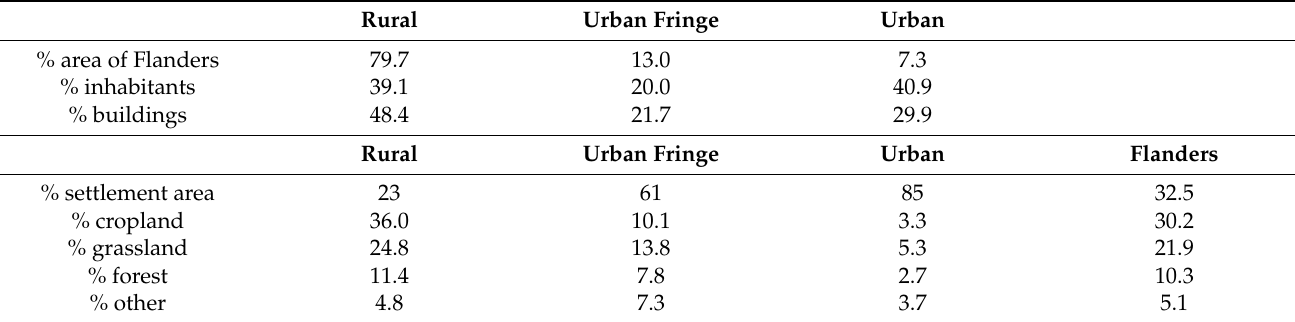
Table 2. Composition of Flanders regarding rural area, urban fringes and urban areas and their characteristics in terms of land cover (data applies to 2013 and was extracted from [22]). This division of Flanders in rural, urban fringe and urban areas does not aim to be directly applicable for spatial policy